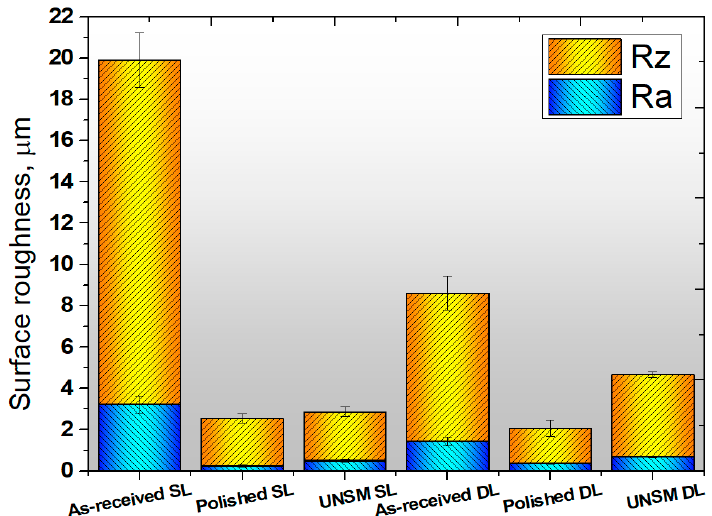
Figure 6. Comparison of surface roughness results of the as-received, polished and UNSM-treated surfaces of the single and double layers.